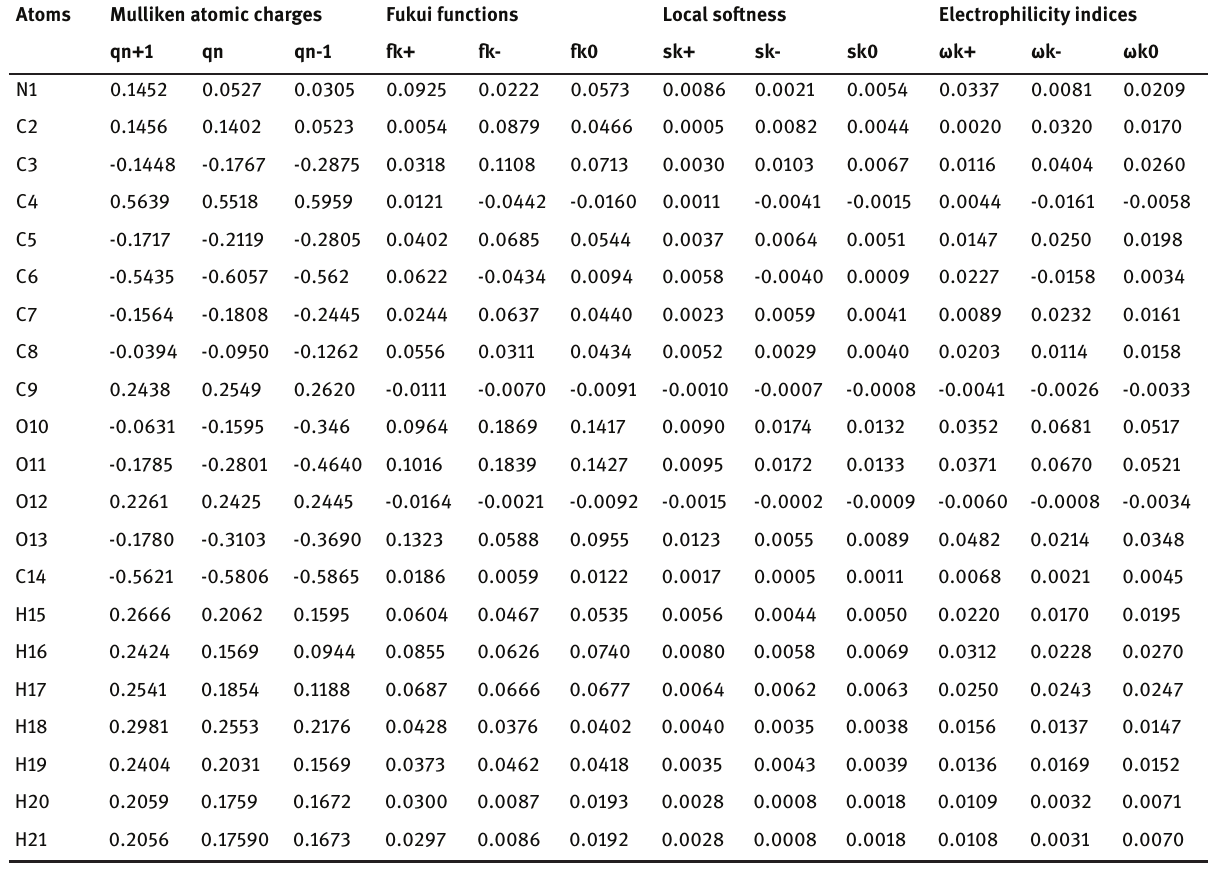
Table 5 : Mulliken population analysis, Fukui functions, local softness in eV, electrophilicity indices in eV for atoms of N -acetylisatin . Atoms Mulliken atomic